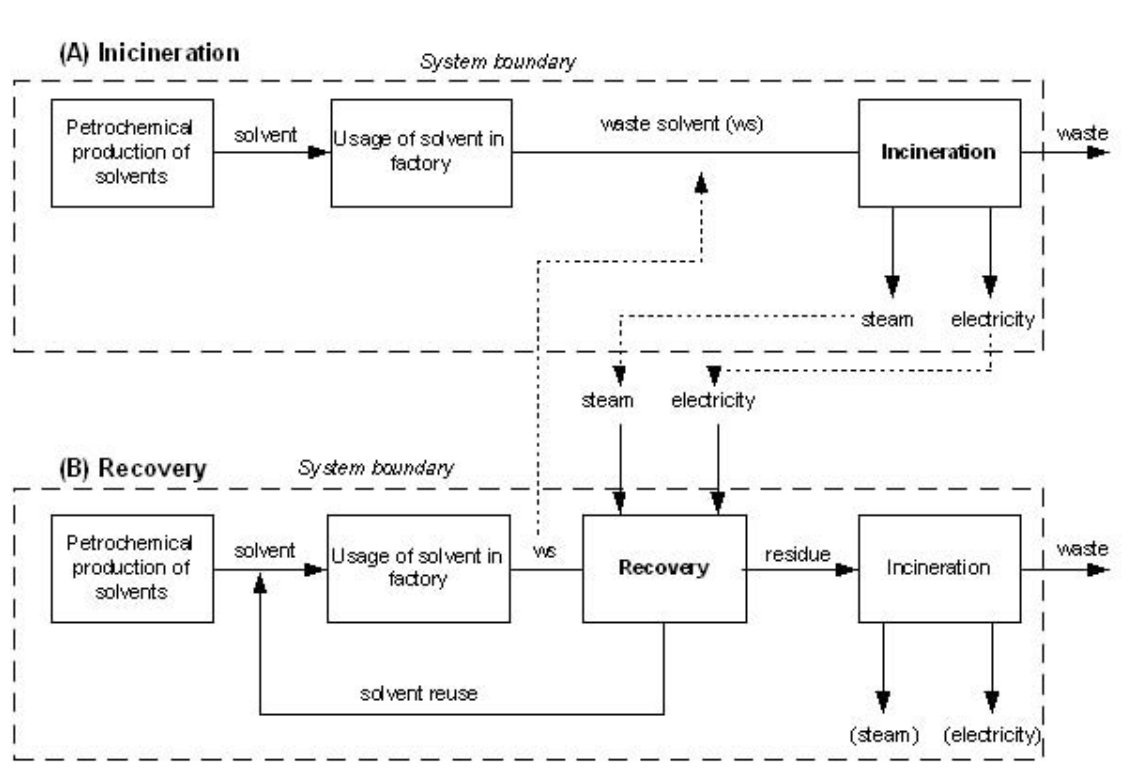
Fig. 4 Model of the waste solvent treatment